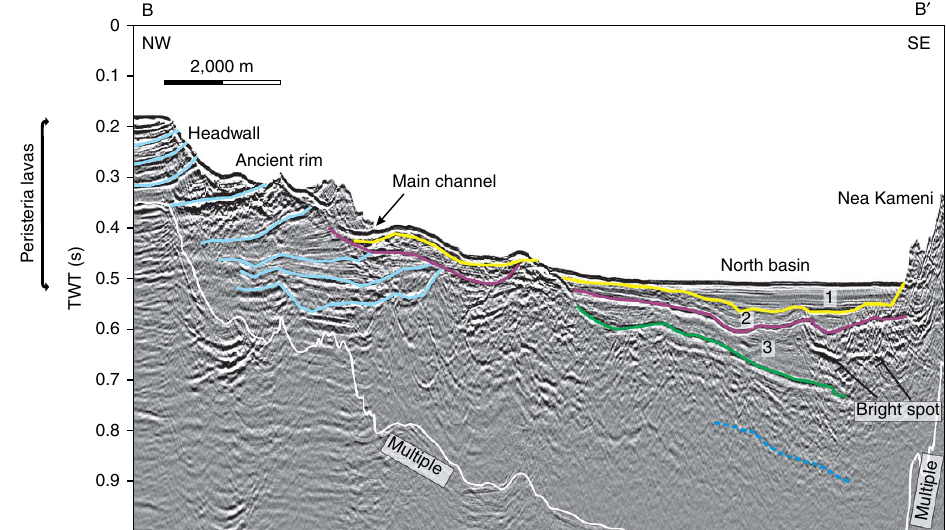
Figure 3 | Interpreted multi-channel reflection seismic profile along the axis of the NW strait. Transect B-B 0 in Fig. 2. Stratigraphic units 1–3 of ref. 10 are shown numbered. The light blue lines indicate stratigraphic horizons within Peristeria lavas, and the dotted dark blue line indicates the presence of a deep, but poorly defined reflector. What appears as an edifice in the upper part of the slope is a ledge of the channel rim. ATWT (two-way travel time) interval of 0.1s corresponds approximately to a water depth interval of 75m or a sediment interval of 100m. Please refer to Supplementary Fig. 1 for the uninterpreted seismic